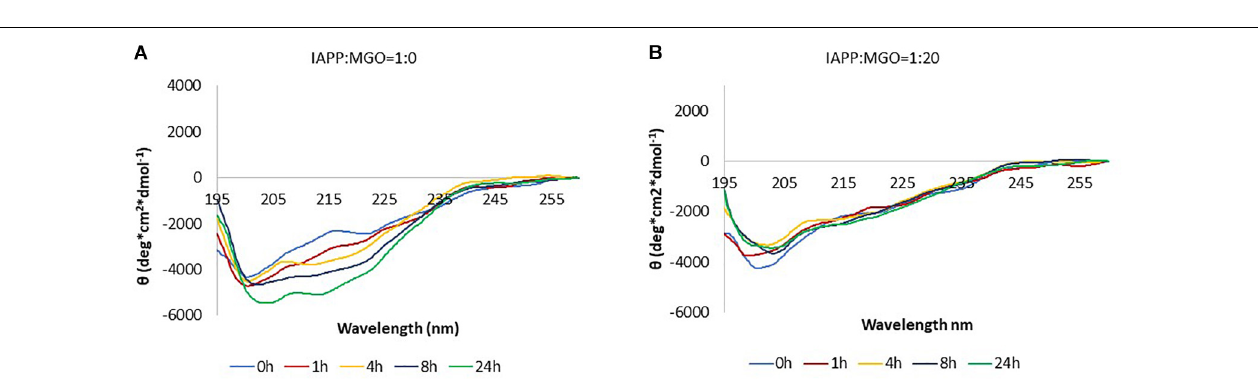
FIGURE 4 | Kinetics of aggregation measured by the variation of the fluorescence signal of ThT. The experiment was carried out using 20 µ M IAPP in 20 mM phosphate at pH 7.4 with (red) and without (black) MGO recorded in the absence (A) and presence (B) of 150 mM NaCl.